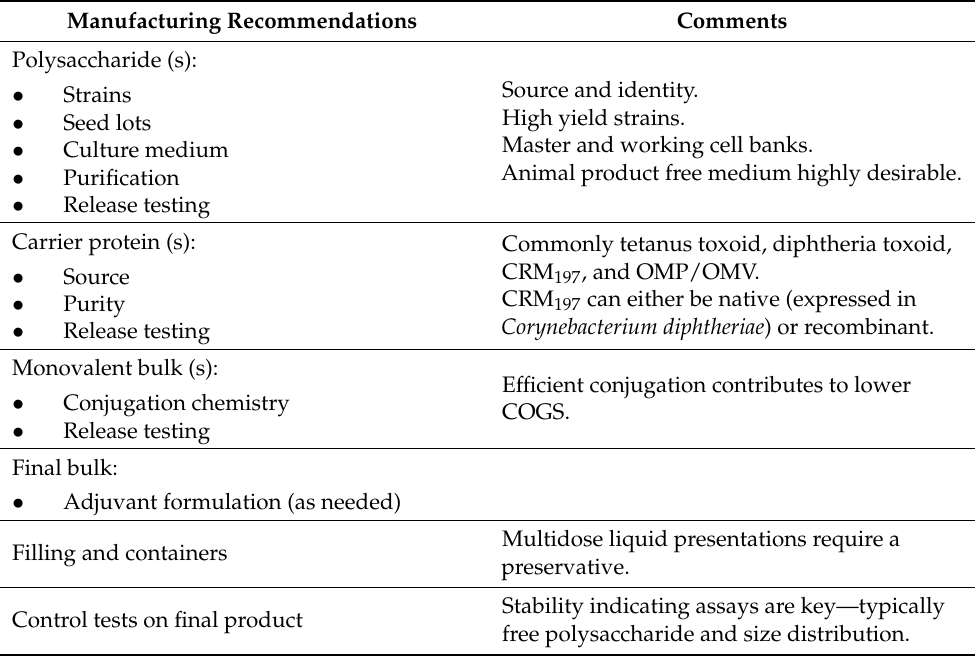
Table 3. CMC general considerations